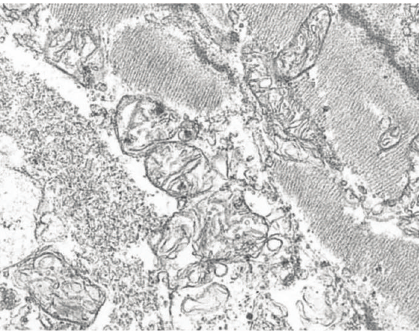
Figure 1: Representative electromicrographs of mitochondrial ultrastructure. Scale bar 200